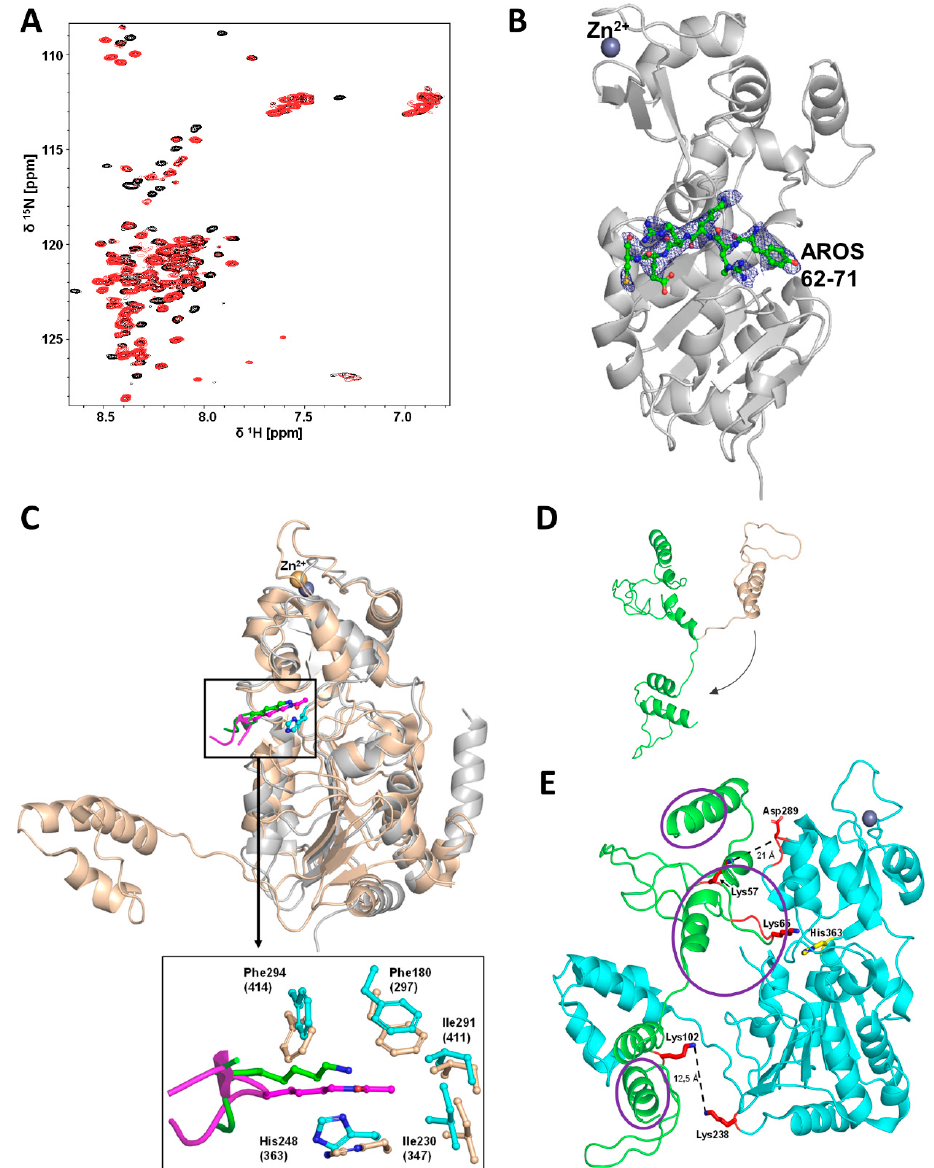
Figure 5. Crystal structure of a Sirt3/AROS peptide complex and modeling of the Sirt1/AROS complex. ( A ) 2D-NMR titration of 15 N-labeled AROS with Sirt3, analogous to the experiment with Sirt1 (see Figure 4A). Shown are molar ratios 1:0 and 1:1 in black and red, respectively. ( B ) Overall structure of the complex between Sirt3 and AROS peptide 62-71 (green sticks). 2Fo-Fc electron density (blue) for AROS62-71 is contoured at 1 σ . ( C ) Overlay of Sirt3 (gray cartoon) in complex with AROS62-71 (green sticks) and miniSirt1 (wheat cartoon) in complex with an acetylated p53 peptide (magenta sticks), generated through secondary structure matching for the Sirtuin cores (other overlaid Sirtuin/peptide complexes omitted for clarity). Enlarged view shows interactions of AROS62-71 and p53 with the Sirtuin active site. The Sirt3 complex is shifted slightly up compared to the Sirt1 complex for visibility. ( D ) Structure prediction for AROS using the program RaptorX (wheat cartoon). The original orientation of the C-terminus was changed manually (arrow) to obtain a more extended conformation (green cartoon) for docking onto Sirt1. ( E ) Modeling of the Sirt1 (cyan; pdb entry: 4zzh) interaction with AROS (green) based on the model in panel D, the Sirt3/AROS crystal structure, and our cross-linking results. Residues implicated in the interaction through cross-links (red) and the catalytic Sirt1 His363 (yellow) are shown as sticks, and regions implicated in the interaction through NMR are circled